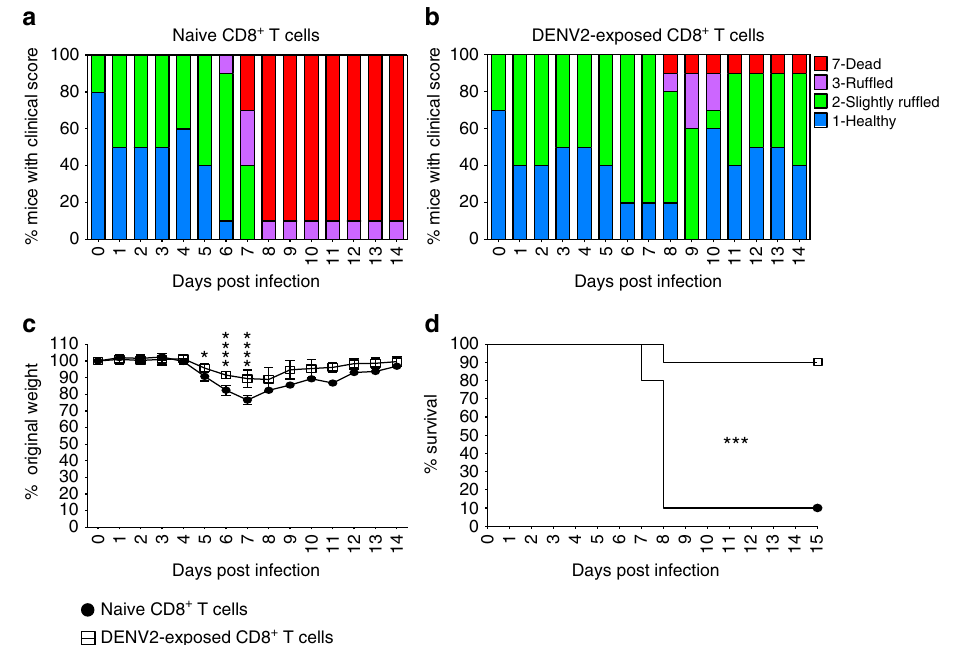
Fig. 5 Decreased ZIKV-induced morbidity and mortality in Ifnar1 − / − mice adoptively transferred with DENV2-exposed CD8 + T cells. Naive or DENV2- exposed CD8 + T cells (1 × 10 7 ) from Ifnar1 − / − mice were adoptively transferred via the retro-orbital route to recipient Ifnar1 − / − mice. One day later, mice were retro-orbitally challenged with 1 × 10 3 FFU of ZIKV FSS13025. Clinical score ( a , b ), weight loss ( c ), and survival rates ( d ) were recorded daily. Mice having > 20% weight loss and/or exhibiting paralysis of two hind limbs were euthanized according to Animal Protocols. This experiment was performed twice with n = 5 mice per group per experiment. Data represent pooled data from 10 mice per group and expressed as mean ± SEM. * p < 0.05, *** p < 0.001, **** p < 0.0001. c Two-way ANOVA. d Log rank test. Supplementary Tables 1 and 2 give exact values of n and and 1:7290. DENV2 S221 or ZIKV FSS13025 was added to diluted sera (2 × 10 4 FFU of DENV2/ZIKV per well). After 1h incubation at 37°C, U937 DC-SIGN cells were seeded in each well (1 ×10 5 cells/well). The plates were incubated for 2h at 37°C (rocking every 15min). Cells without serum were used as positive control. After incubation, the plates were centrifuged for 5min at 300× g , and supernatants were aspirated. Fresh medium was added to plates and incubated for 16 h at 37°C. After fi xation and permeabilization using Cyto fi x/Cytoperm solution (BD Biosciences), cells were stained with anti-CD209 PE (a dilution of 1:100) and a mixture of 4G2 FITC/2H2 FITC (1 μ g/ml). Cells were analyzed on an LSRII fl ow cytometer (BD Biosciences, CA, USA) and the percentages of infected cells were